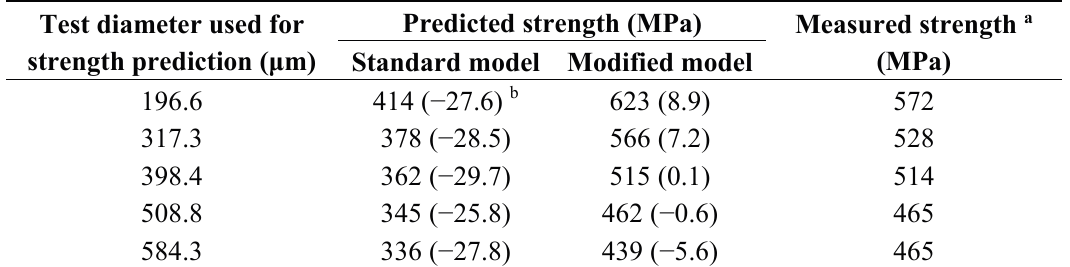
Table 6. Comparison of measured and predicted tensile strength at different test